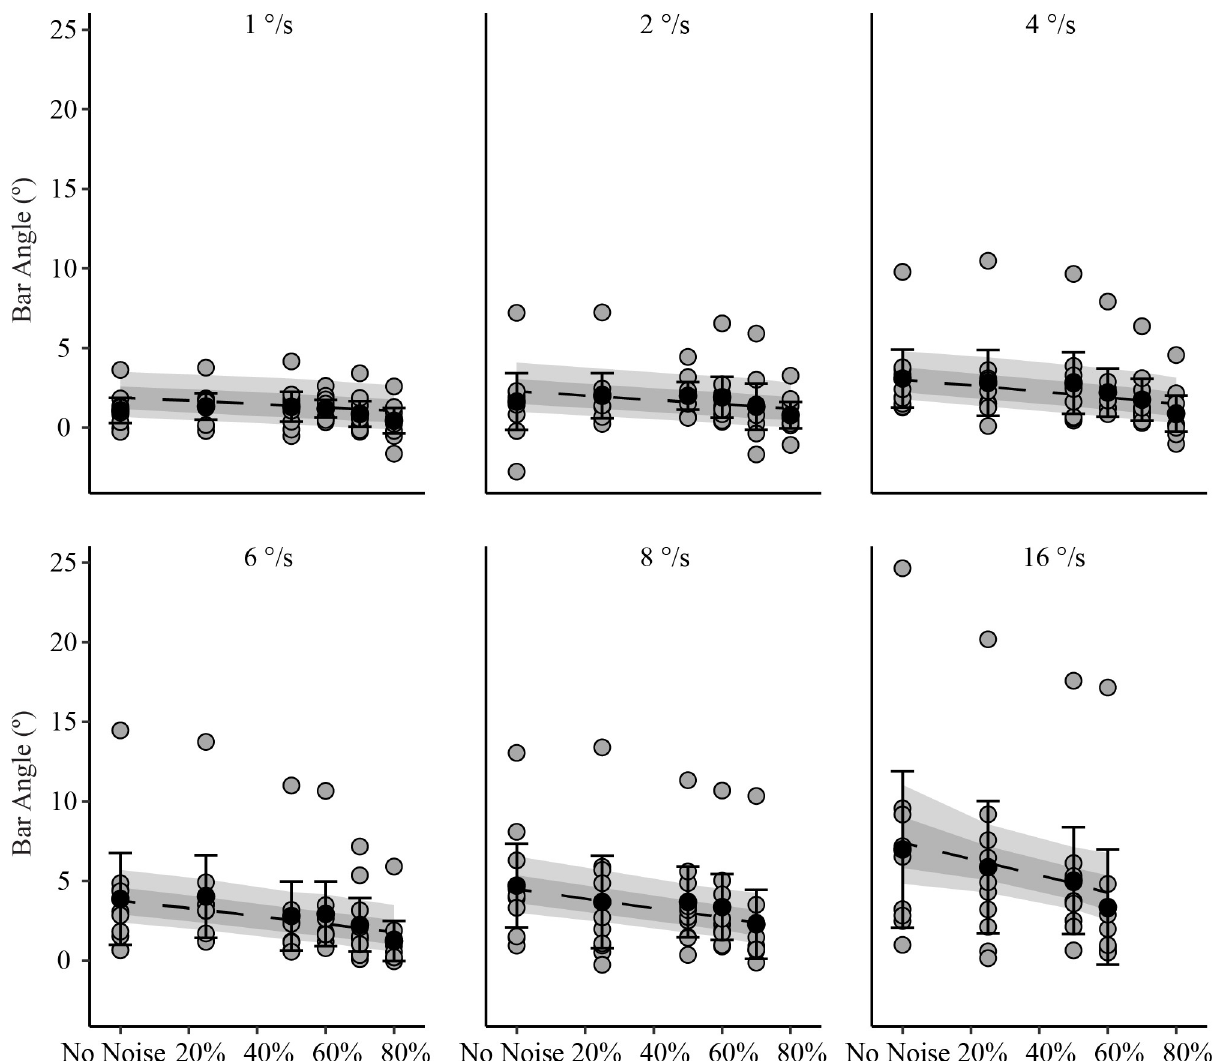
Fig 3. Linear multilevel mixed effects model with sample mean and individual data displaying the effect of adding noise on perceived vertical. Noise decreased the influence on visual motion on perceived vertical but the size of the effect depends on the velocity. Each subject’s mean bar angle for the last 13s of visual motion in each trial are shown as grey circles. Sample means are black circles (n = 10). The error bars are standard deviations. The segmented line is the bootstrapped linear multilevel mixed effects model mean and the shaded regions are the 68% and 95% confidence intervals for the